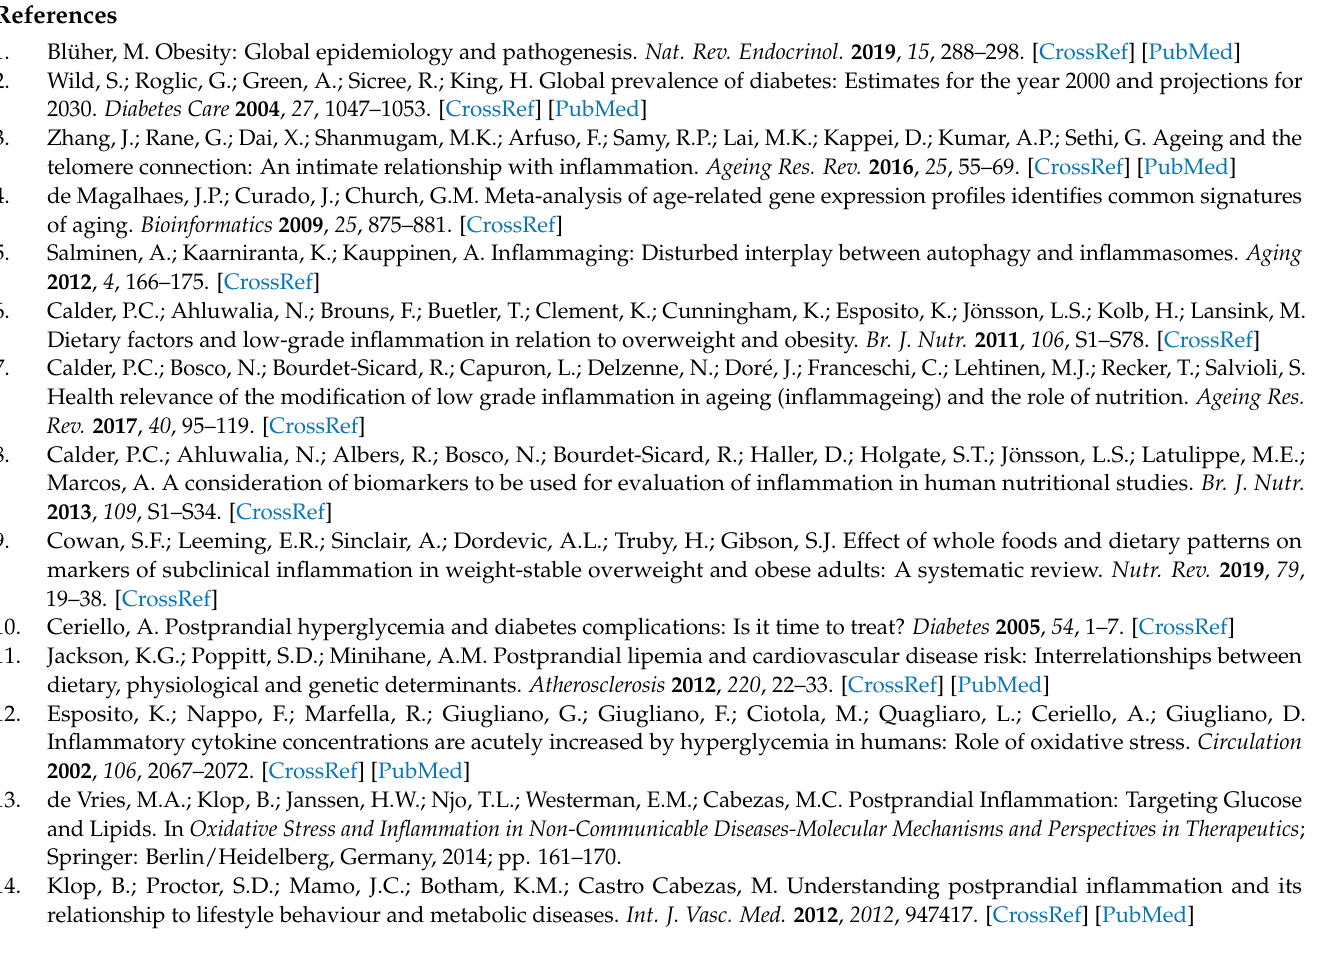
markers; Table S1: Dietary inflammatory index calculation for the Pro-meal; Table S2: Dietary inflam- matory index calculation for the Neutr-meal; Table S3: Dietary inflammatory index calculation for the Anti-meal; Table S4: Postprandial inflammatory and metabolic measures for the Anti-meal,